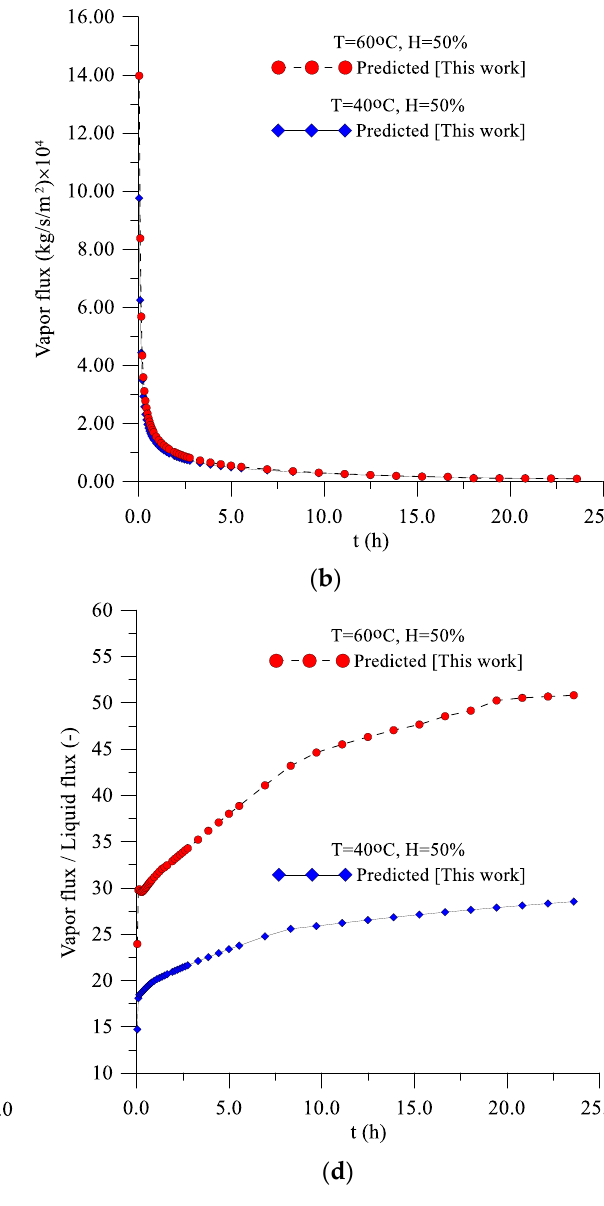
Figure 6. ( a ) Liquid flux, ( b ) vapor flux, ( c ) total flux, and ( d ) relationship between the vapor flux and the liquid flux, on the surface of the lentil grain for drying at 40 °C and a relative humidity of 50%.